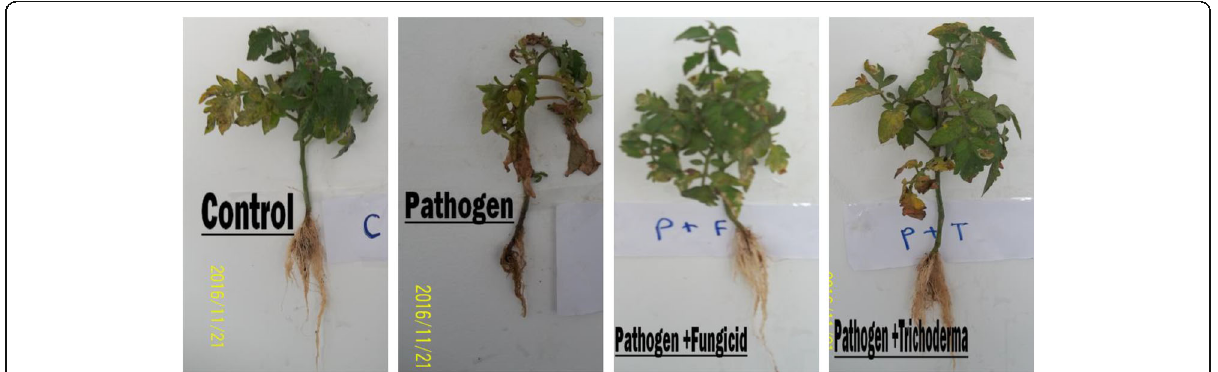
Fig. 6 Effect of T. atroviride on growth parameters of tomato plant infected with F.